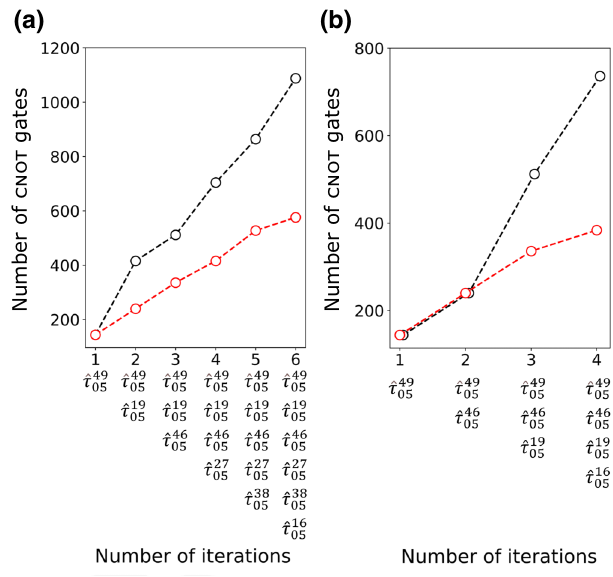
FIG. 11. Number of nearest-neighbor CNOT gates versus the number of iterations (with operator set included) used in the ADAPT VQE to iteratively build the | ψ ADAPT ((cid:8) 4 ) (cid:8) ansatz. We consider the default (black) and permuted (red) qubit Hamil- tonians of the LiH molecule in a reduced active space of the STO-3G basis (ten qubits) assuming a linear qubit connectivity. The set of operators is generated on the basis of (a) a state vector (noiseless) simulator and (b) the Qasm (noisy) simulator; ˆ τ ab